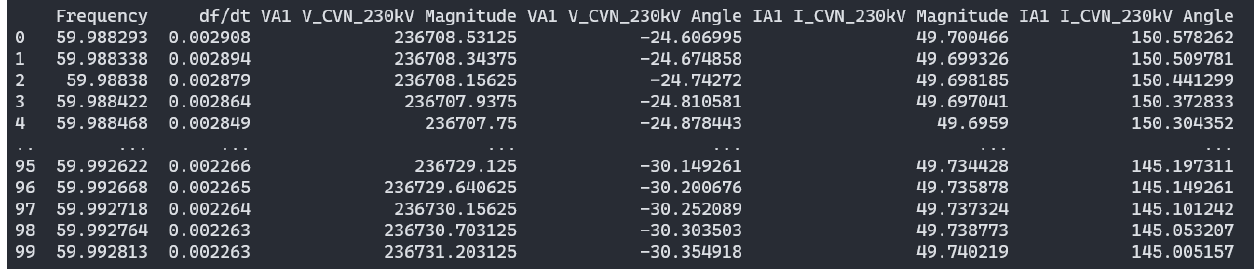
Figure 2. Data of frequency, rate of change of frequency (df/dt), magnitude and angle of voltage and current of phase